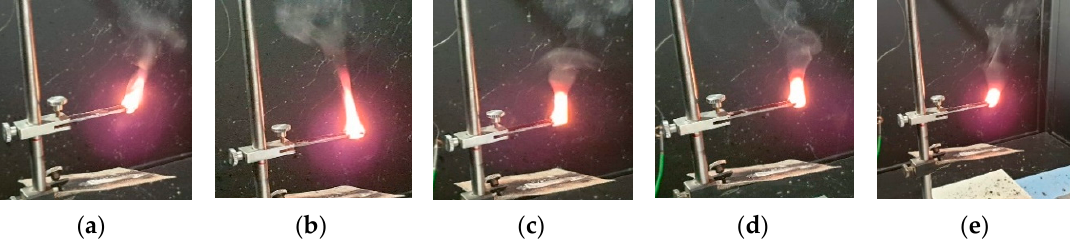
Figure 9. Photos of burning polymers during the tests. ( a ) 0%P + 0%L, ( b ) 0%P + 5%L, ( c ) 0%P + 5%L P , ( d ) 2%P + 5%L, ( e ) 2%P + 5%L P